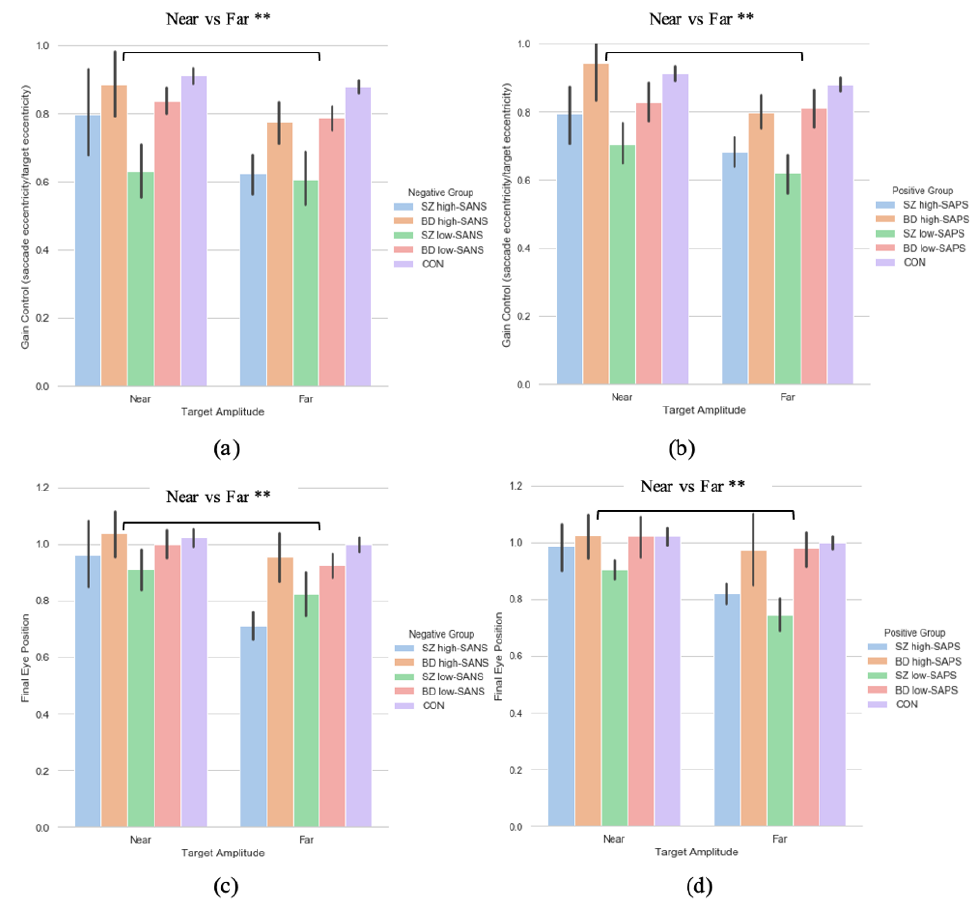
Figure 4. A comparison of performance in gain control for both the ( a ) negative symptom groups and the ( b ) positive symptom groups, as well as performance in the final eye position measure in both the ( c ) negative symptom groups and the ( d ) positive symptom groups, between the two extremities within each diagnostic group. For reference the control cohort are included here but were not included in the reported analysis. ** Refers to significance at the p < 0.01 level. Error bars refer to standard error.